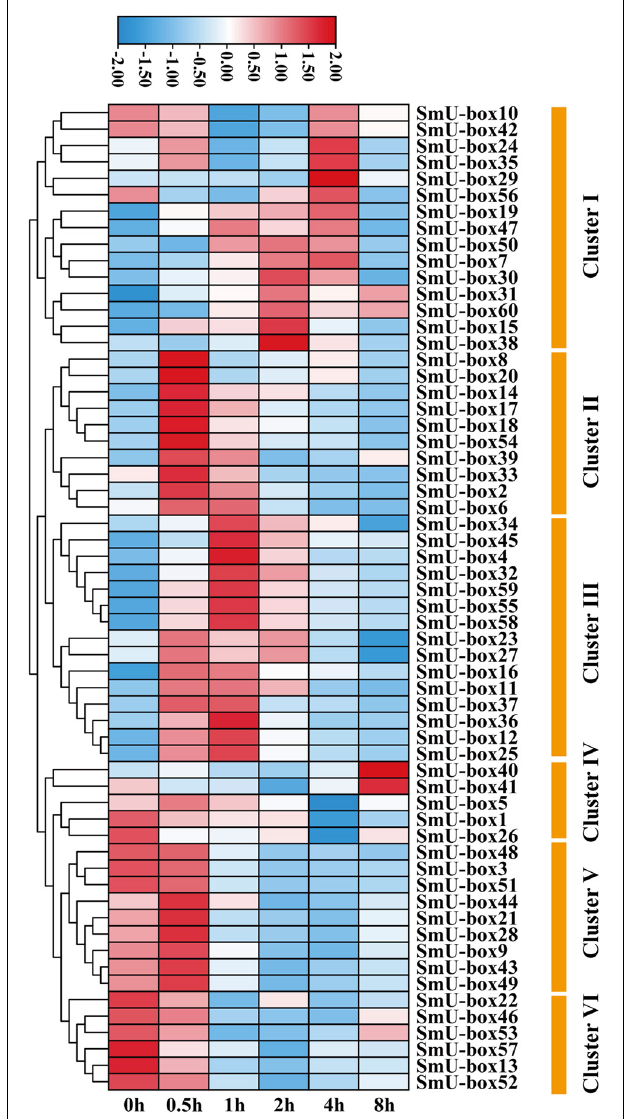
FIGURE 4 | The heat map of U-box genes in S. miltiorrhiza under ABA treatments based on RNA-seq. Genes with similar expression patterns were clustered into the same group according to the hierarchical clustering method. The top color scale indicated the Fragments Per Kilobases per Million reads (FPKM) values of each